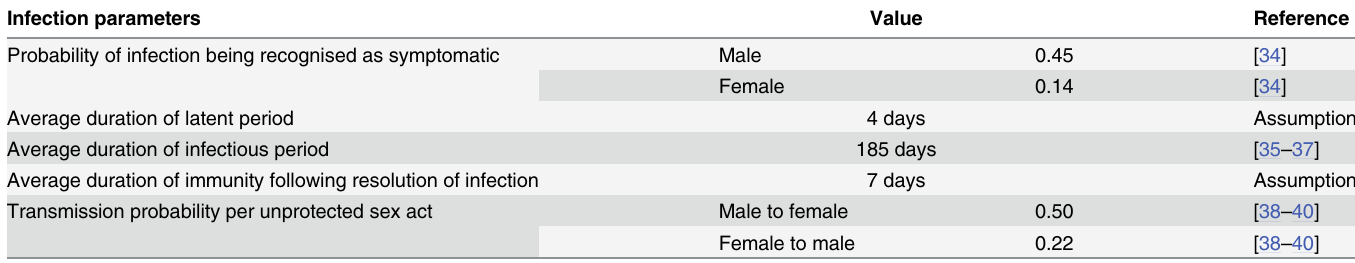
Table 2. Infection parameters for treatment-sensitive and treatment-resistant